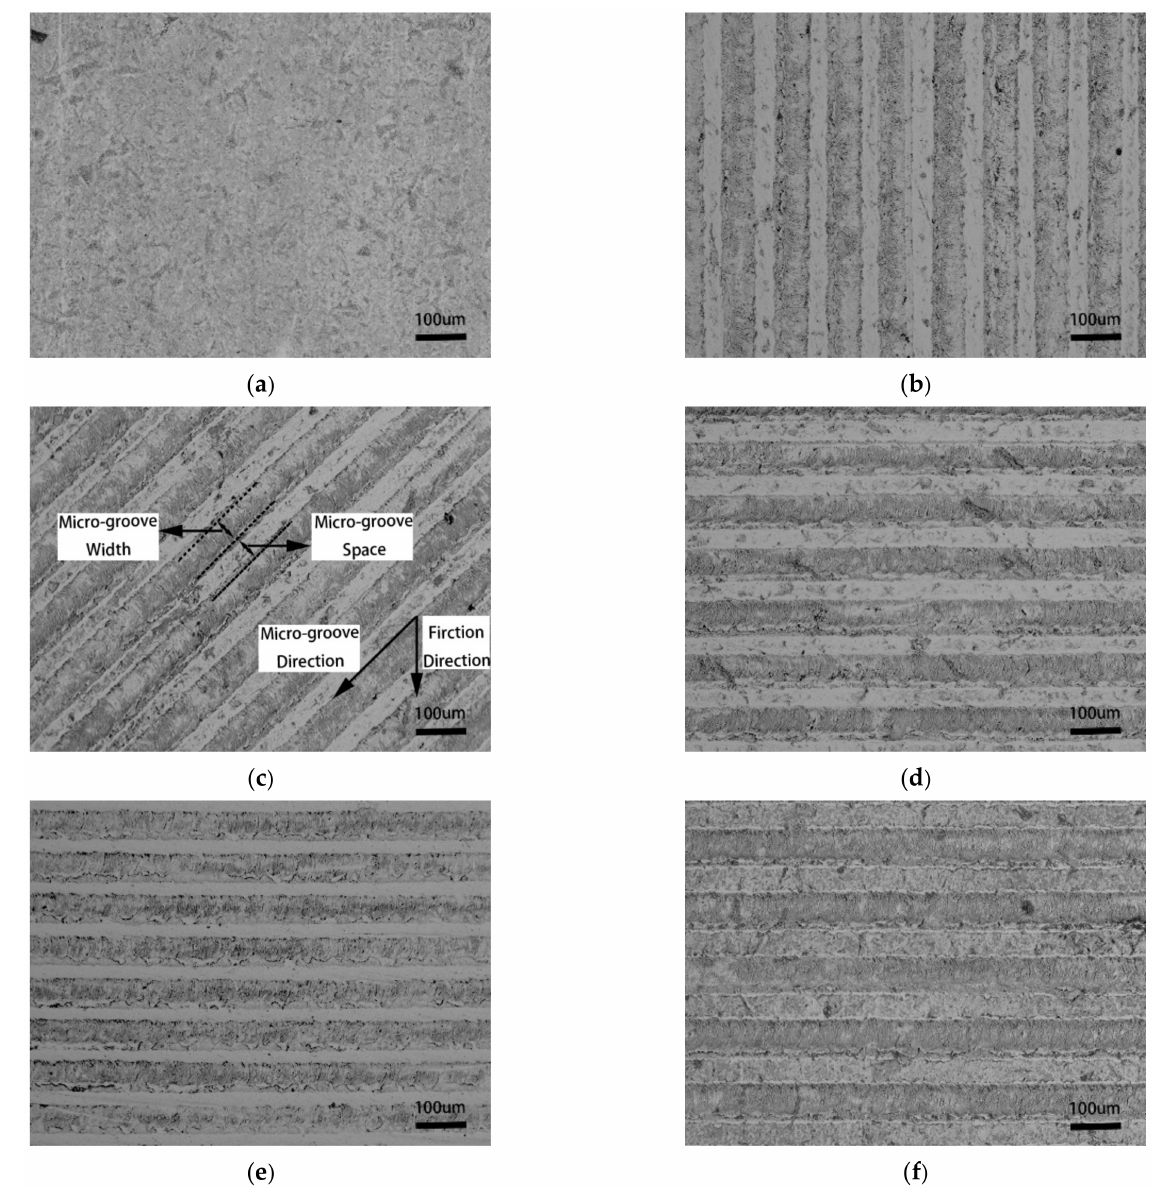
Figure 1. The surface morphology of micro-groove cemented carbide. ( a ) Conventional surface; ( b ) PE micro-grooves; ( c ) OB micro-grooves; ( d ) PA-1 micro-grooves; ( e ) PA-2 micro-grooves; ( f ) PA-3